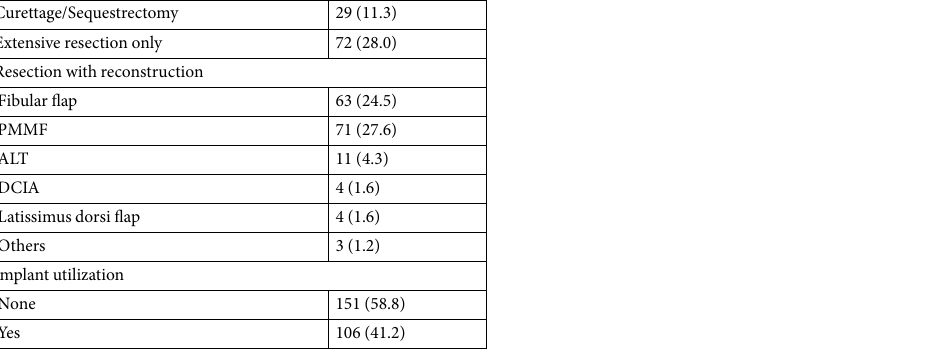
Table 3. Therapeutic methods and implant utilization. * PMMF: pectoralis major myocutaneous flap; * ALT: anterolateral thigh flap; * DCIA: deep circumflex iliac arteryperforator